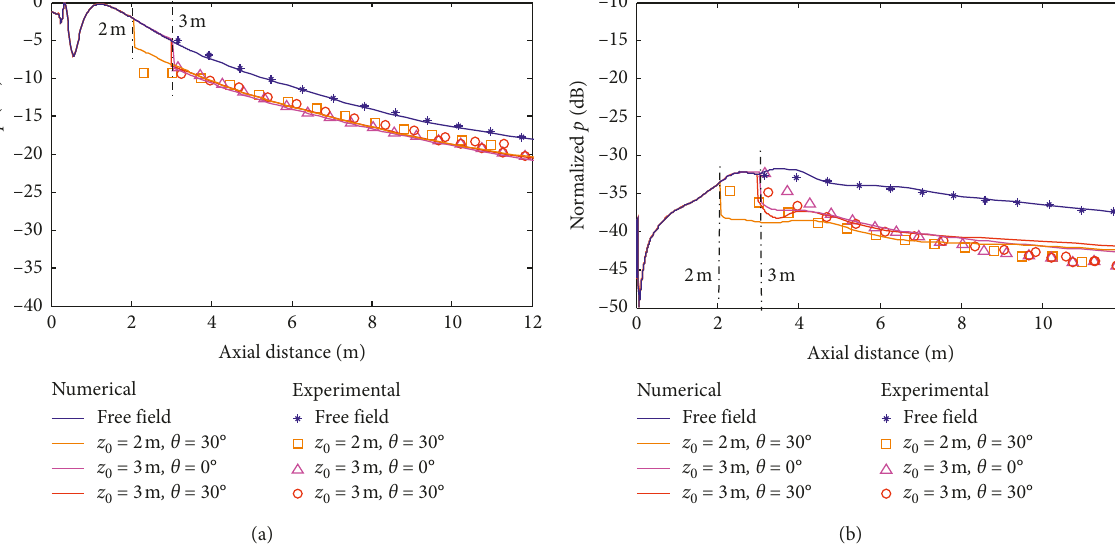
d z e l i m a r N o